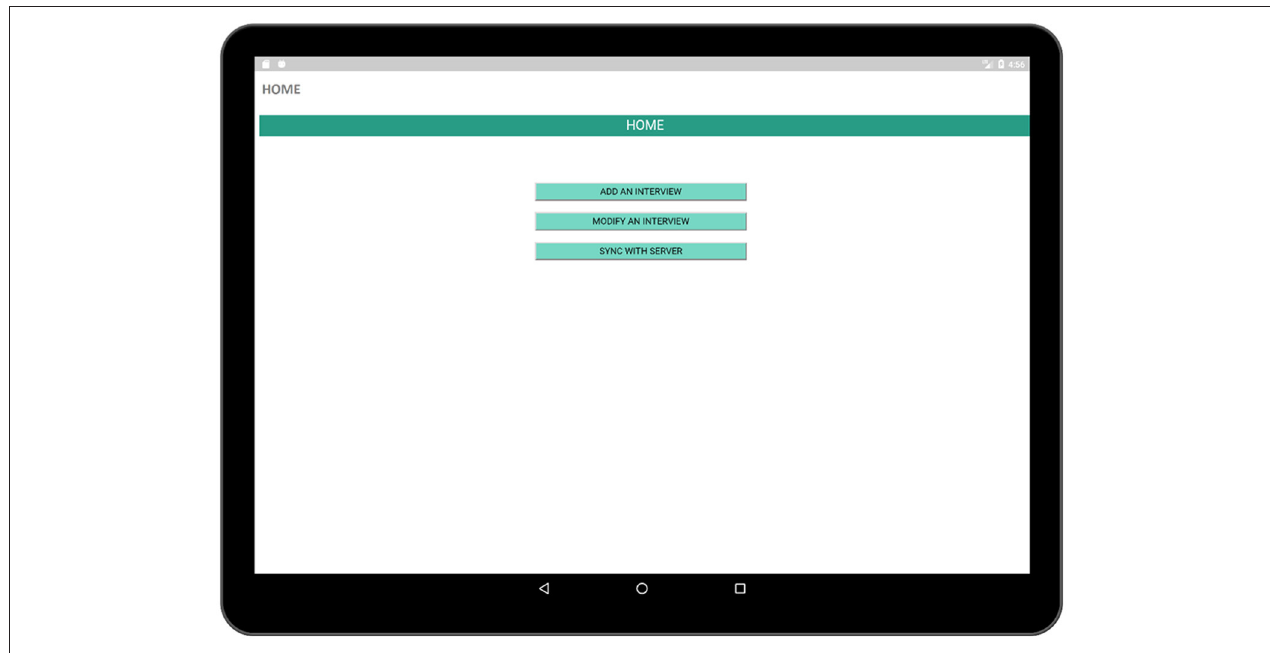
FIGURE 3 | Home activity (contains a list of tasks performed using the app).